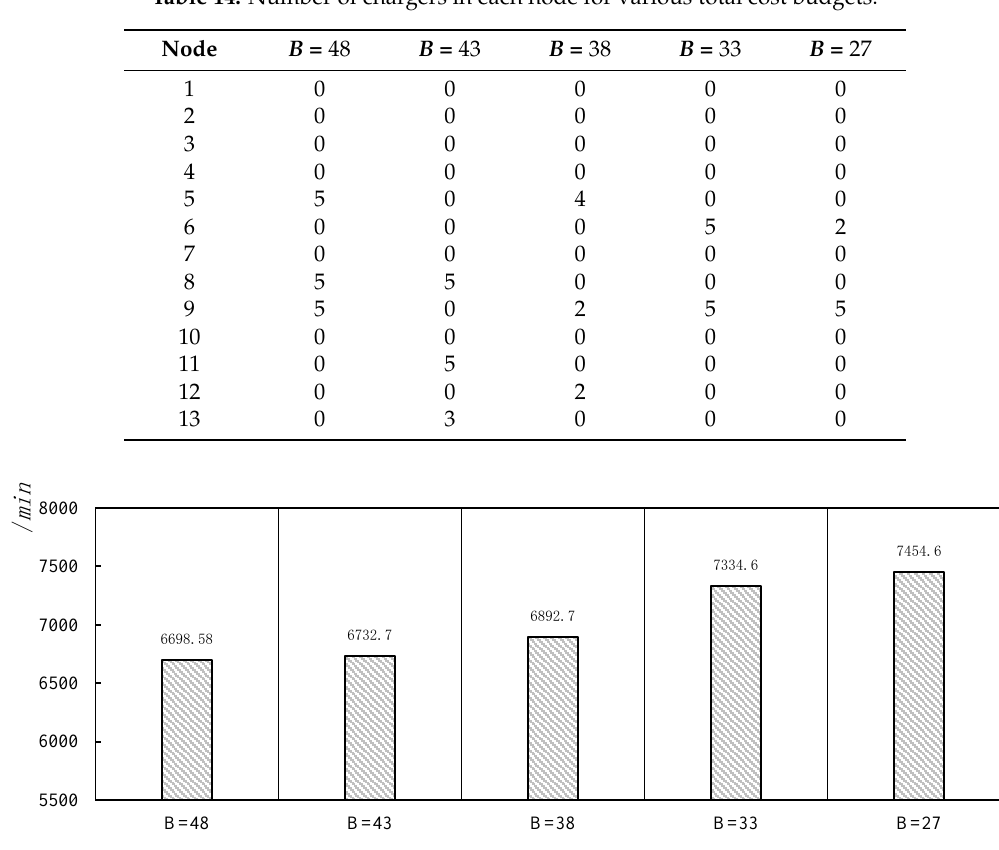
Table 14. Number of chargers in each node for various total cost budgets.